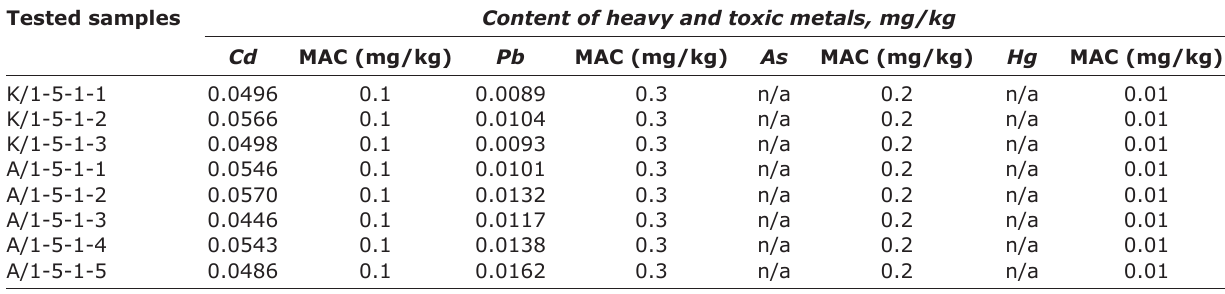
Table-2: Data regarding the content of toxic heavy metals in cottage cheese from the basic farms in the Almaty region. Tested